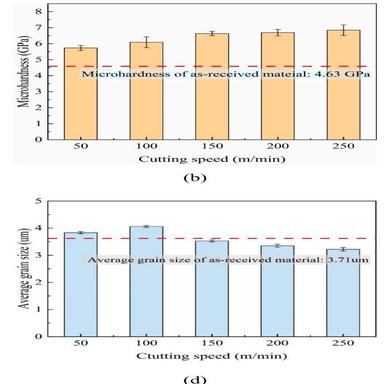
Multiscale characterization of mechanical behaviors and microstructures of the machined surface at different cutting speeds. (a) Residual stresses. (b) Microhardness. (c) The grain orientation maps. (d) The average grain size of machined surface.